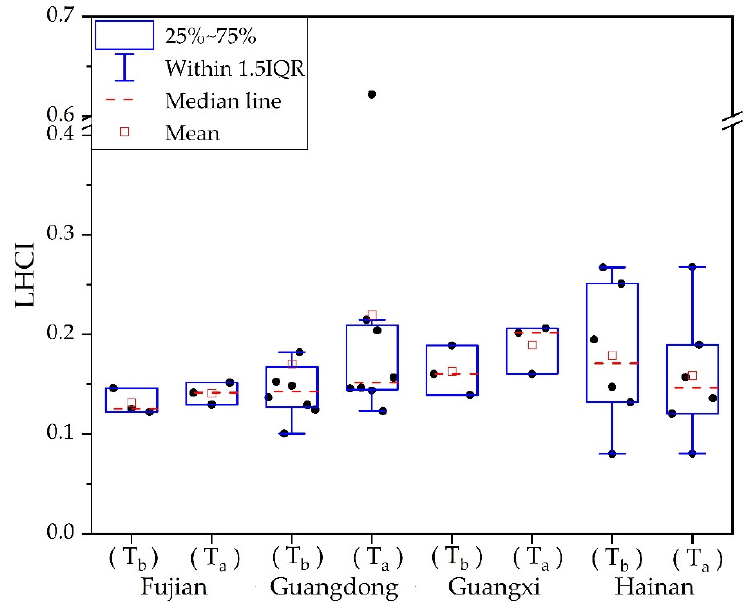
Figure 3. Changes of the LHCI in the reserves of different provinces before and after the establishment of